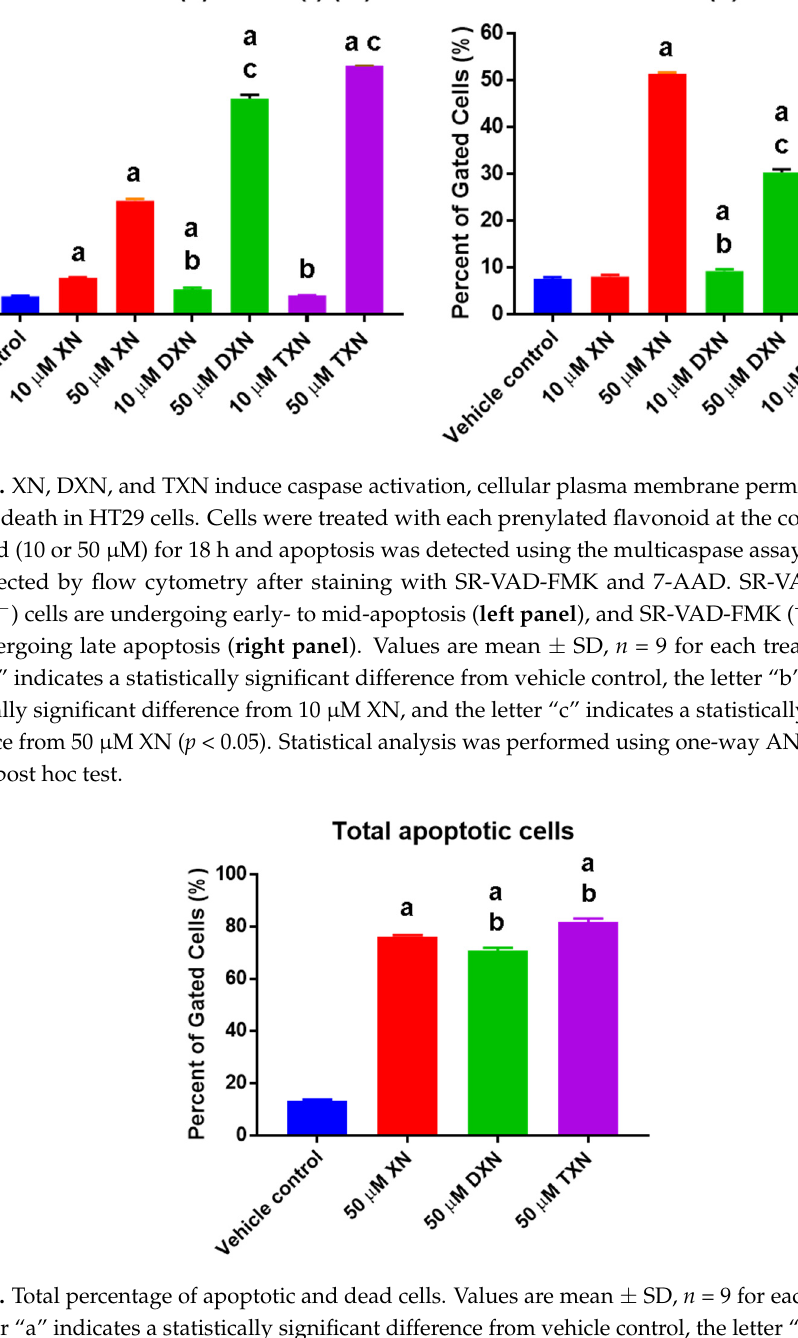
Figure 4. Total percentage of apoptotic and dead cells. Values are mean ± SD, n = 9 for each condition. The letter “a” indicates a statistically significant difference from vehicle control, the letter “b” indicates a statistically significant difference from 50 μ M XN ( p < 0.05). Statistical analysis was performed using one ‐ way ANOVA with a Sidak’s post hoc test.